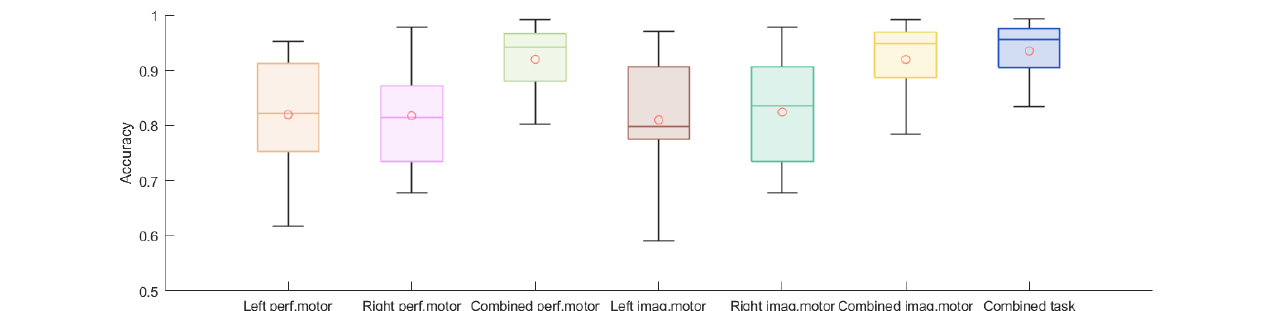
Figure 11. Boxplots of 15 subjects’ accuracies averaged over 5 imposters for left performed motor, right performed motor, combined performed motor, left imagined motor, right imagined motor, combined imagined motor, and combined